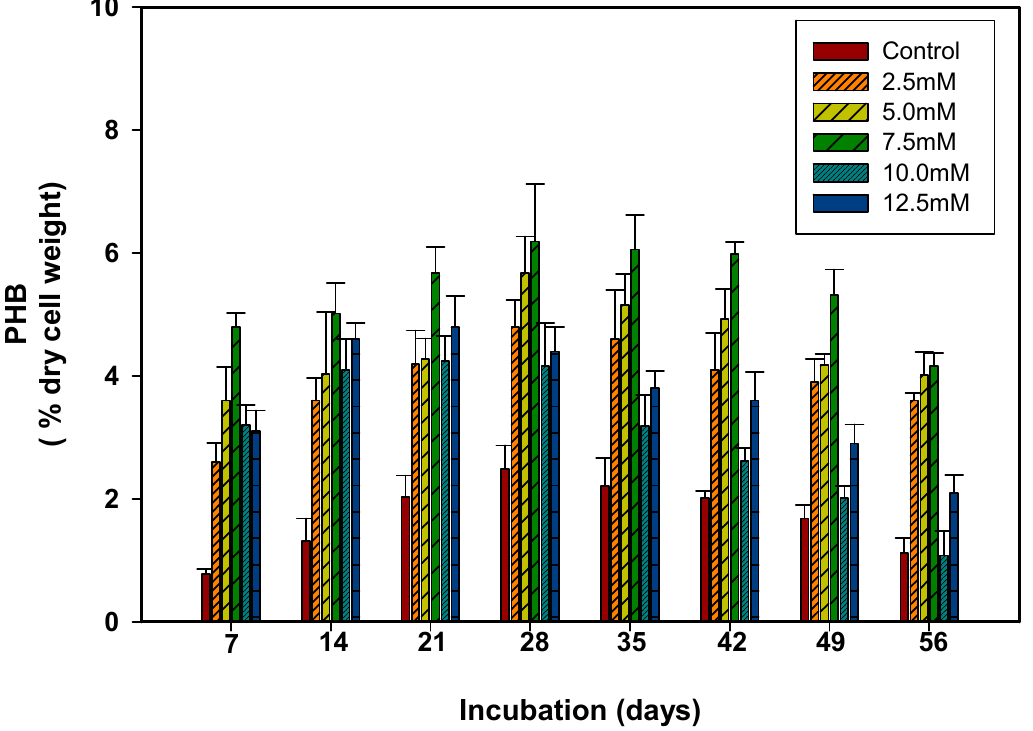
Incubation (days) Figure 3. Production of PHB in S. geitleri in response to sucrose. Values are the mean ( n = 3) ± SD.